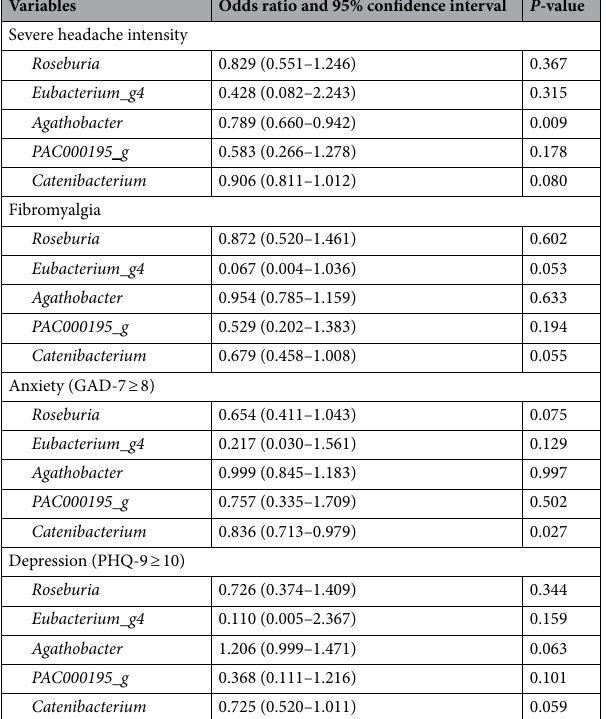
Table 3. The association of severe headache intensity and comorbidities with the relative abundance of microbiota*. GAD-7 Generalized Anxiety Disorder-7; PHQ-9 Patient Health Questionnaire-9. *Logistic regression analyses at the genus